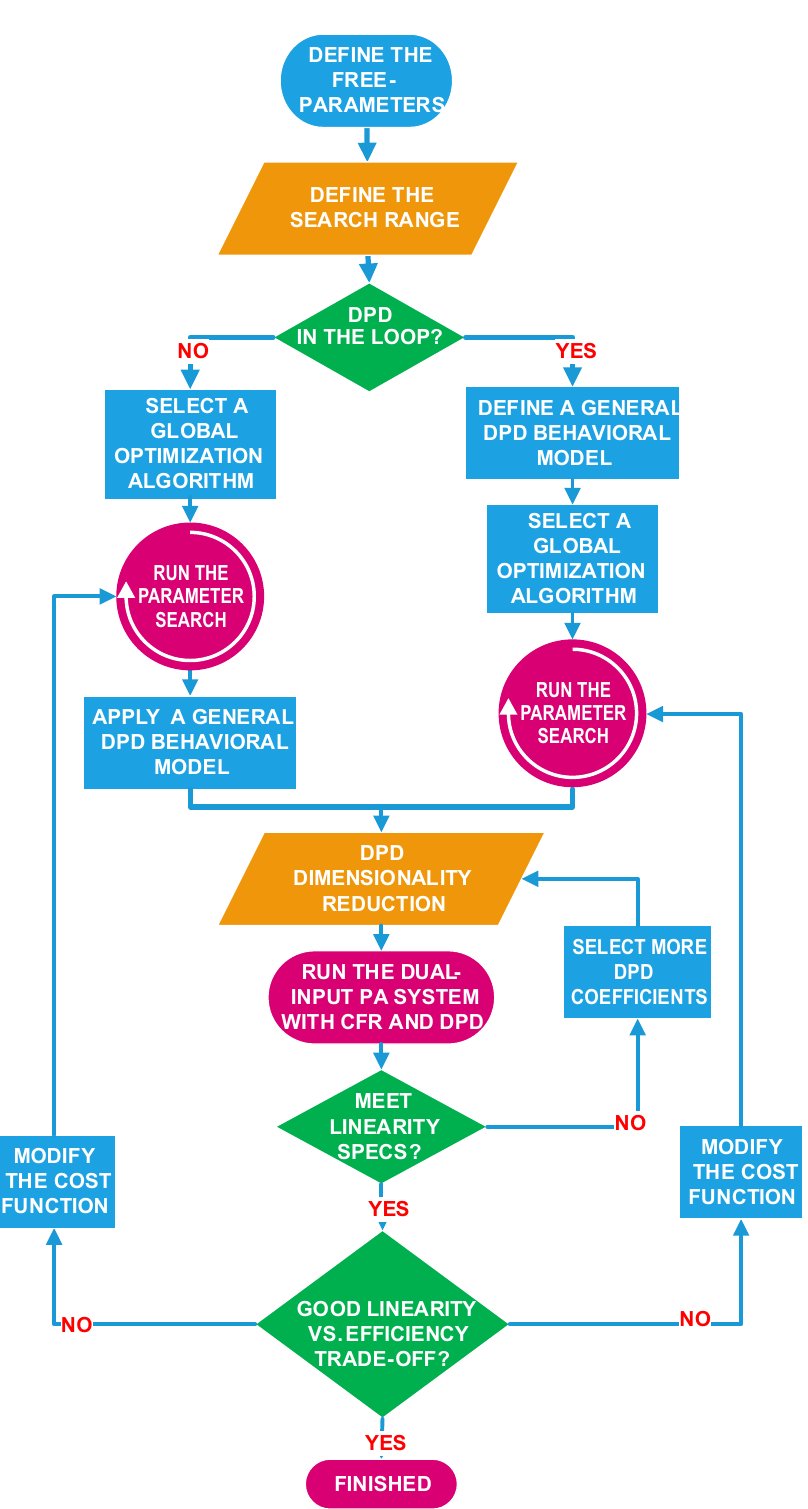
Figure 3. Flowchart of the proposed auto-tuning technique for dual-input